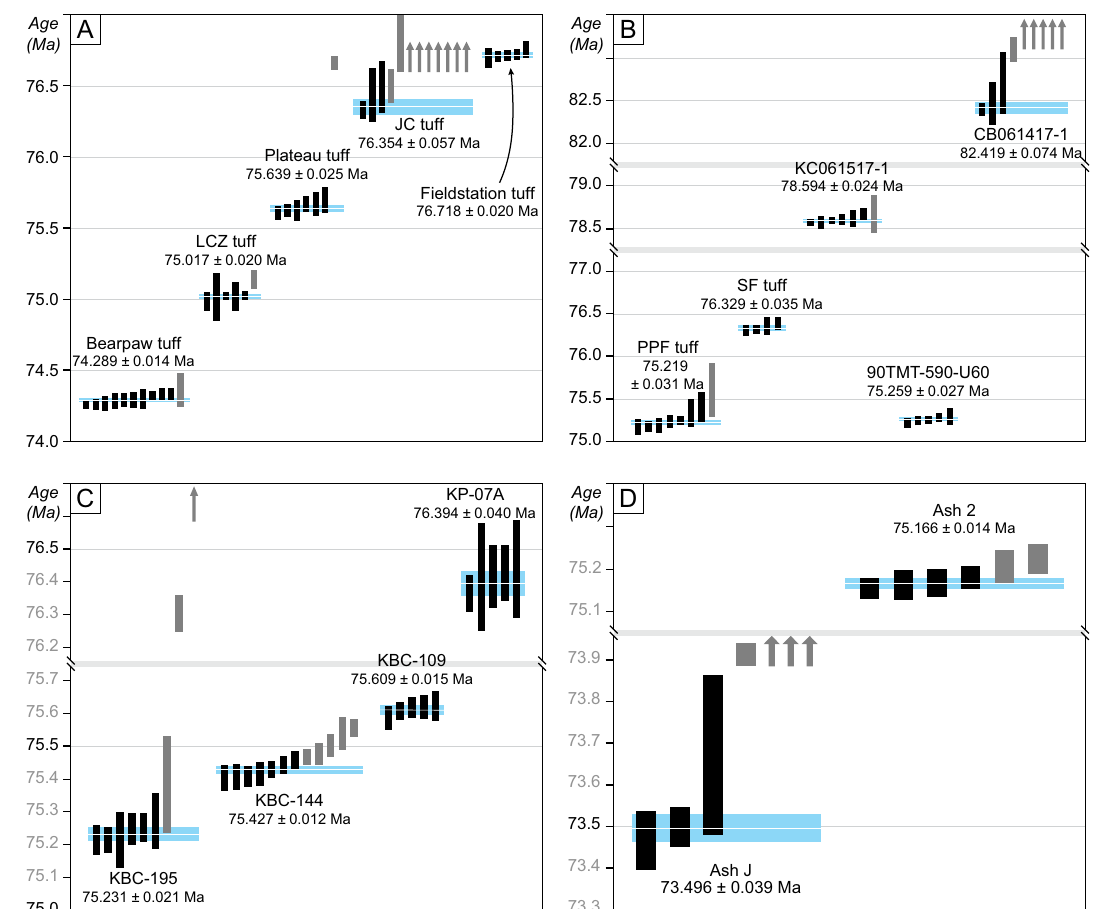
Figure 3. Ranked age plot of analyzed zircons from Campanian ash beds of the Western Interior Basin. ( A ) Dinosaur Provincial Park, southern Alberta, Canada; ( B ) Two Medicine and Judith River formations, Montana; ( C ) Kaiparowits Formation, southern Utah; ( D ) Kirtland and Fruitland formation, San Juan Basin, New Mexico. Vertical bars are individual zircon analyses with their 2σ analytical uncertainty; black bars are analyses used in age calculation. Arrows represent the analyses that plot outside the diagram. Blue band signifies the weighted mean age with its 95% confidence level (2σ) internal uncertainty ( X ). See Table 1 for bentonite and age information, and Supplementary Table S2 for complete U–Pb isotopic data. JC, Jackson Coulee; LCZ, Lethbridge Coal Zone; PPF, Power Plant Ferry; SF, Stafford